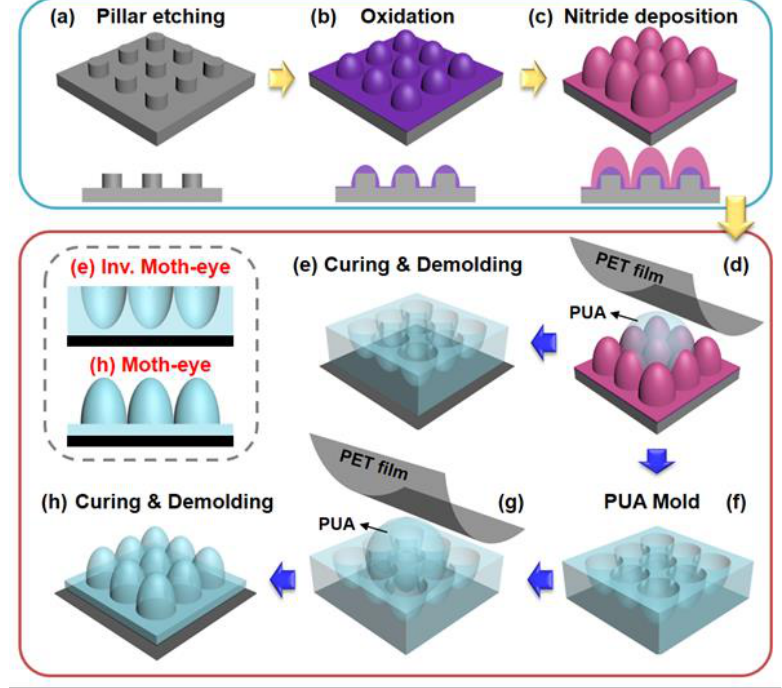
Figure 1. Schematics of silicon master (blue box) and MPS/IMPS fabrication processes (red box). ( a ) Cylindrical, regular pillar fabrication using photolithography and reactive ion etching on a silicon wafer surface; ( b ) Transformed cone-shaped oxidizing pillar on the silicon surface based on thermal oxidation; ( c ) Nitride deposition with the use of LPCVD to increase the height of the moth-eye structures; ( d – h ) PUA replication process using soft lithography based on the prepared silicon master mold. Isometric ( h : curing and demolding) and cross-sectional shape ( e , f : Inverse MPS and MPS) of IMPS ( e ) and MPS ( h ), respectively.